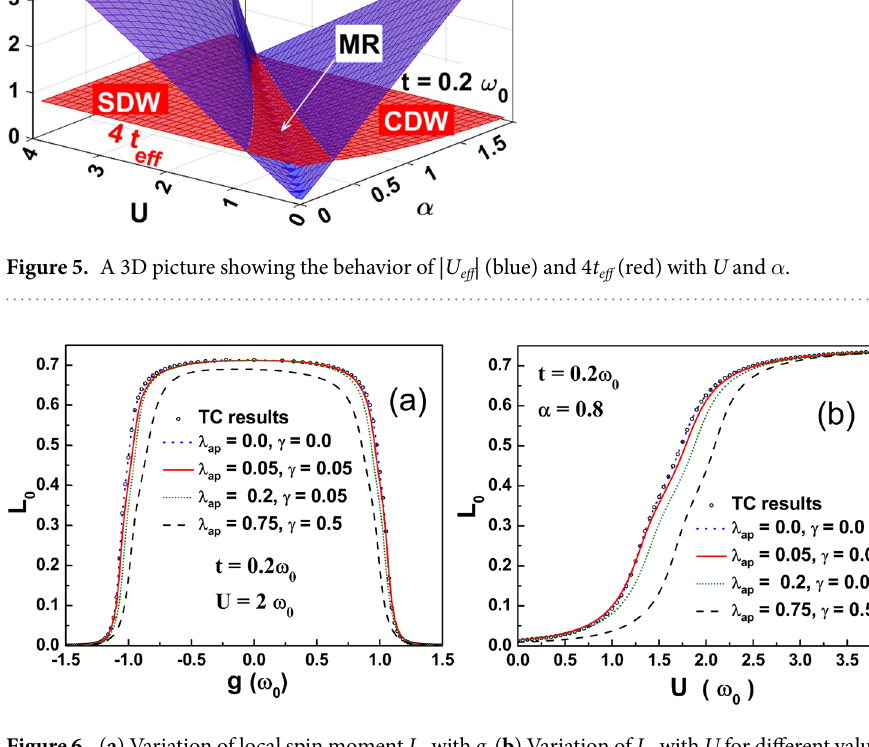
Figure 6. ( a ) Variation of local spin moment L 0 with g . ( b ) Variation of L 0 with U for different values of λ ap and γ